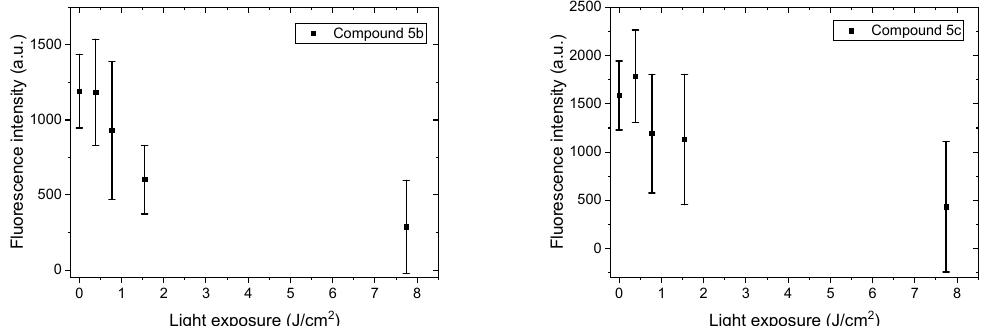
Figure 8. Bleaching data of compounds 5b - ( Left ) and 5c - ( Right ) incubated WiDr cells. The standard deviations are based on 3–5 experiments from data presented in Figure 7.